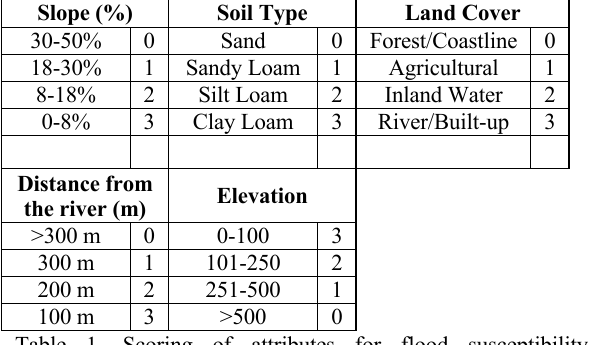
Table 1. Scoring of attributes for flood susceptibility generation